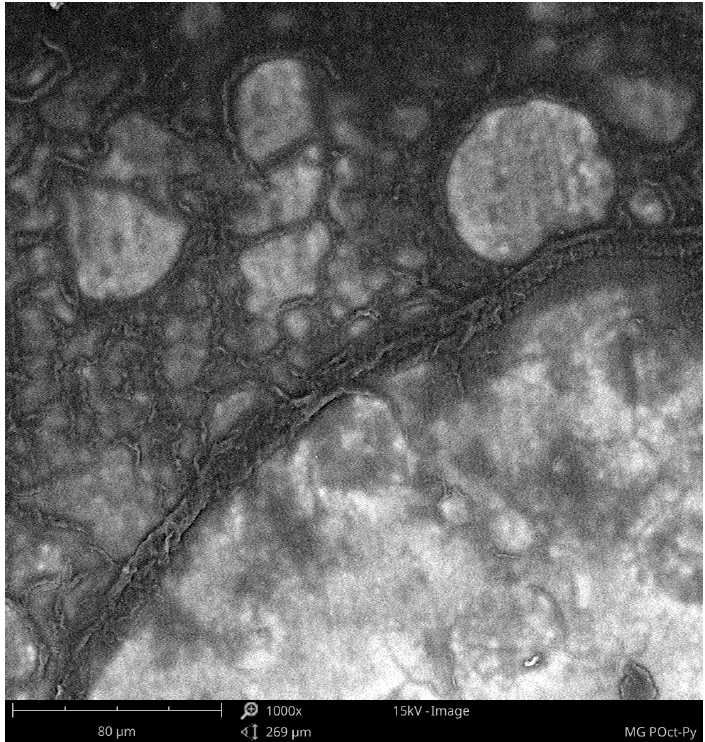
Figure 6. SEM photo of a poly(3-n-octylopyrrole), zoom ×1000.